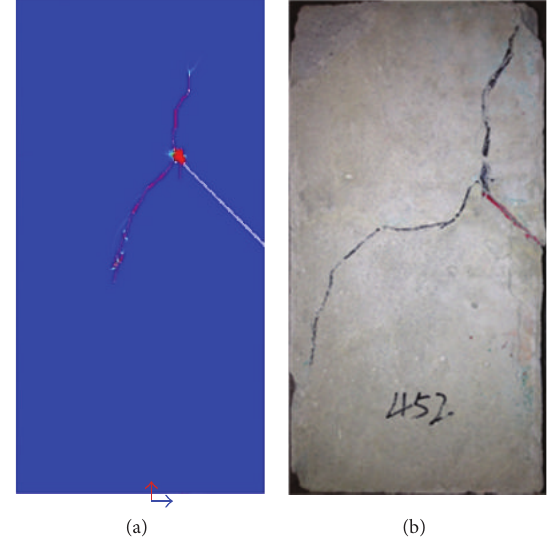
Figure 5: Failure of fissured rocks: photos and numerical simulation. Uniaxial compression test (a) and true triaxial unloading test